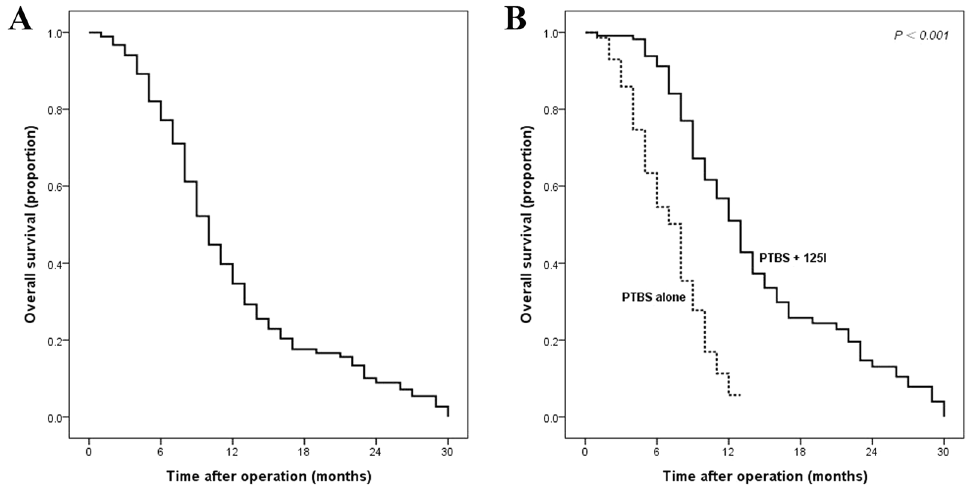
Figure 2. The survival curves of advanced EHC patients. Overall survival curves for the whole cohort ( A ), and stratified according to treatment method ( B